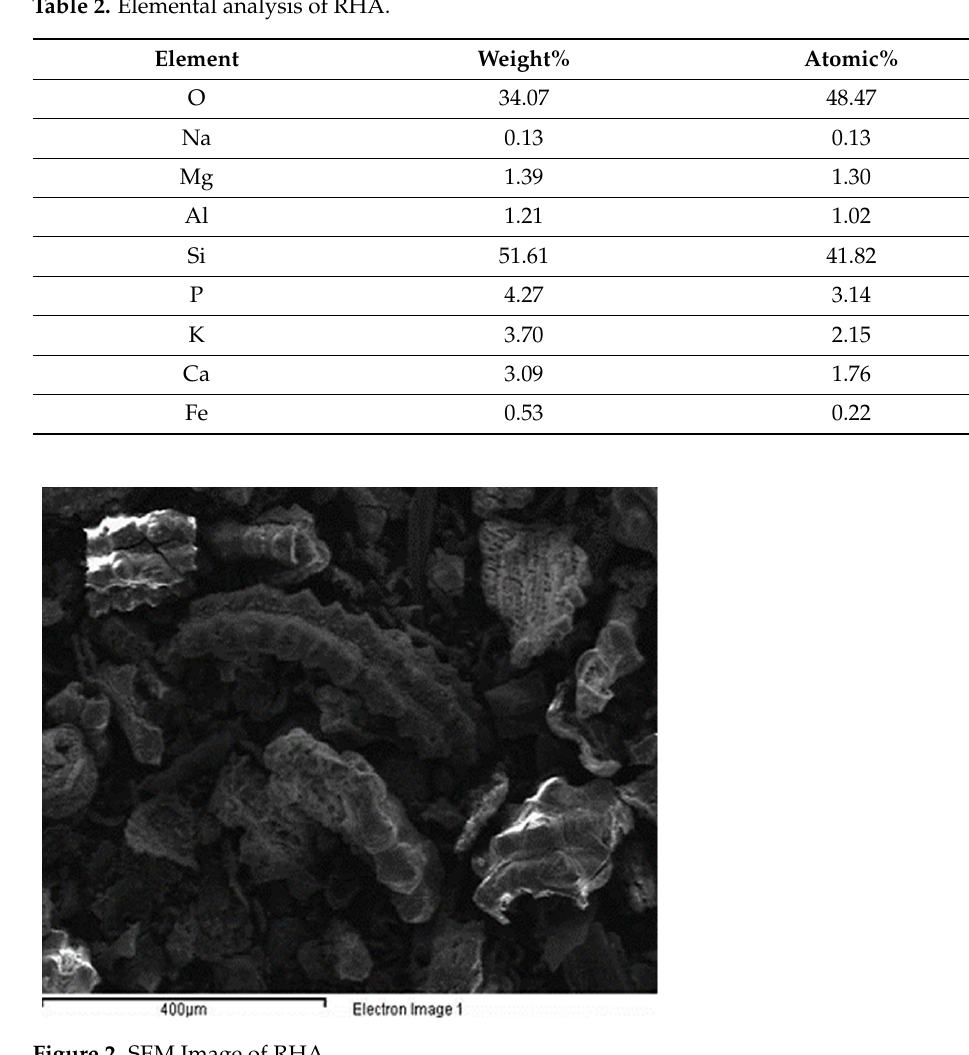
Figure 2. SEM Image of